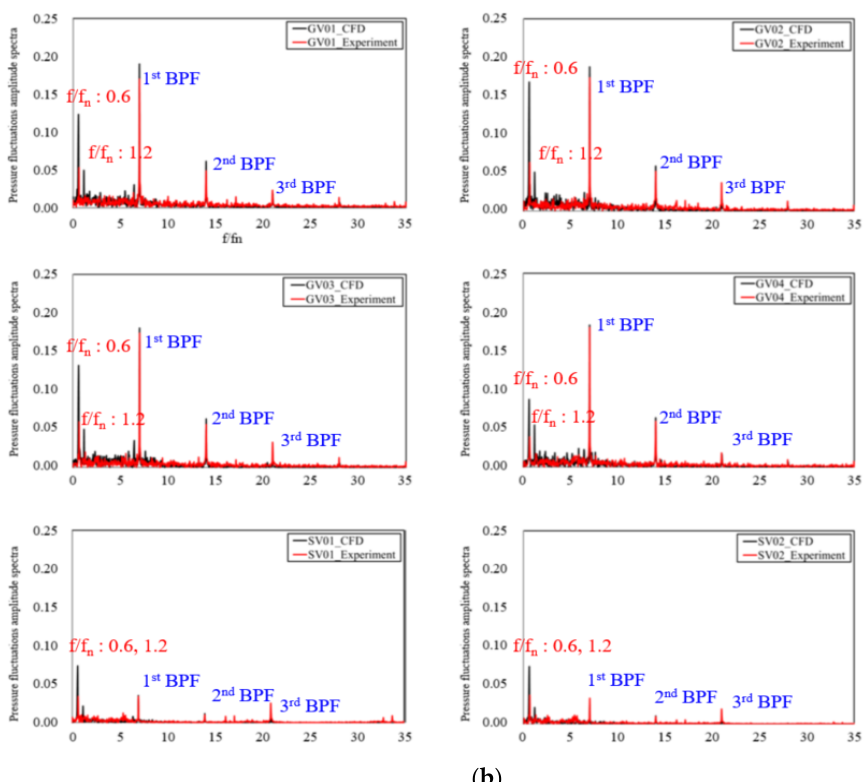
Figure 14. Frequency spectra of the pressure fluctuations under the runaway condition (obtained by the fast Fourier transform): ( a ) Full-scale model; ( b ) laboratory-scale model.